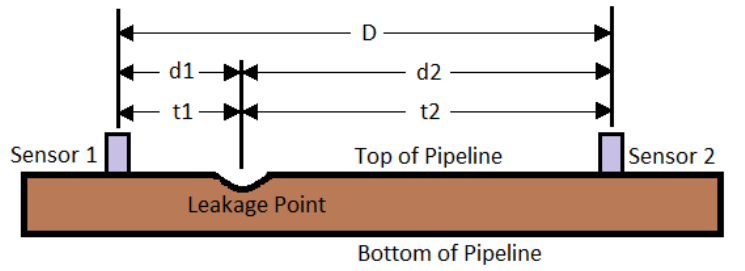
Figure 17. The experimental setup for the identification of the location of the leakage based on the difference in arrival times of acoustic signals, over distances d 1 and d 2. Modified from